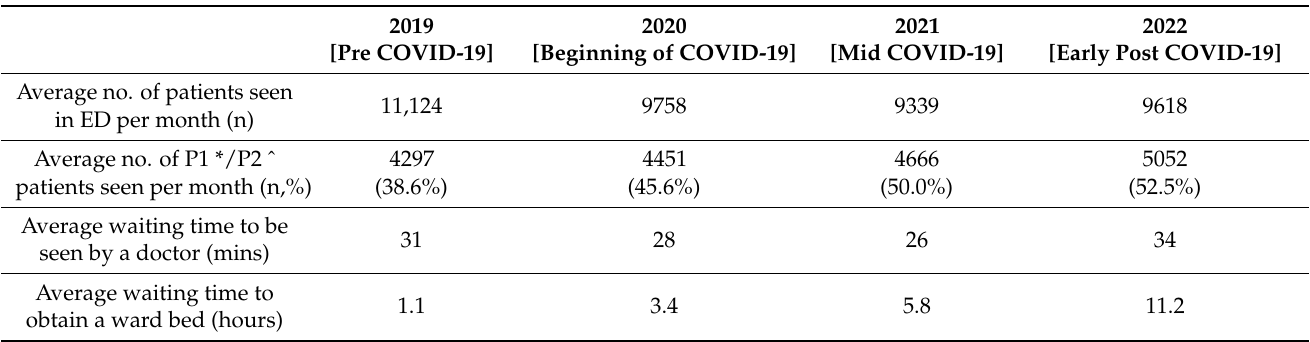
Table A2. Average number of ED patients seen per month, average waiting time to see a doctor in ED (in minutes) and average waiting time to obtain a ward bed (in hours) from 2019 to